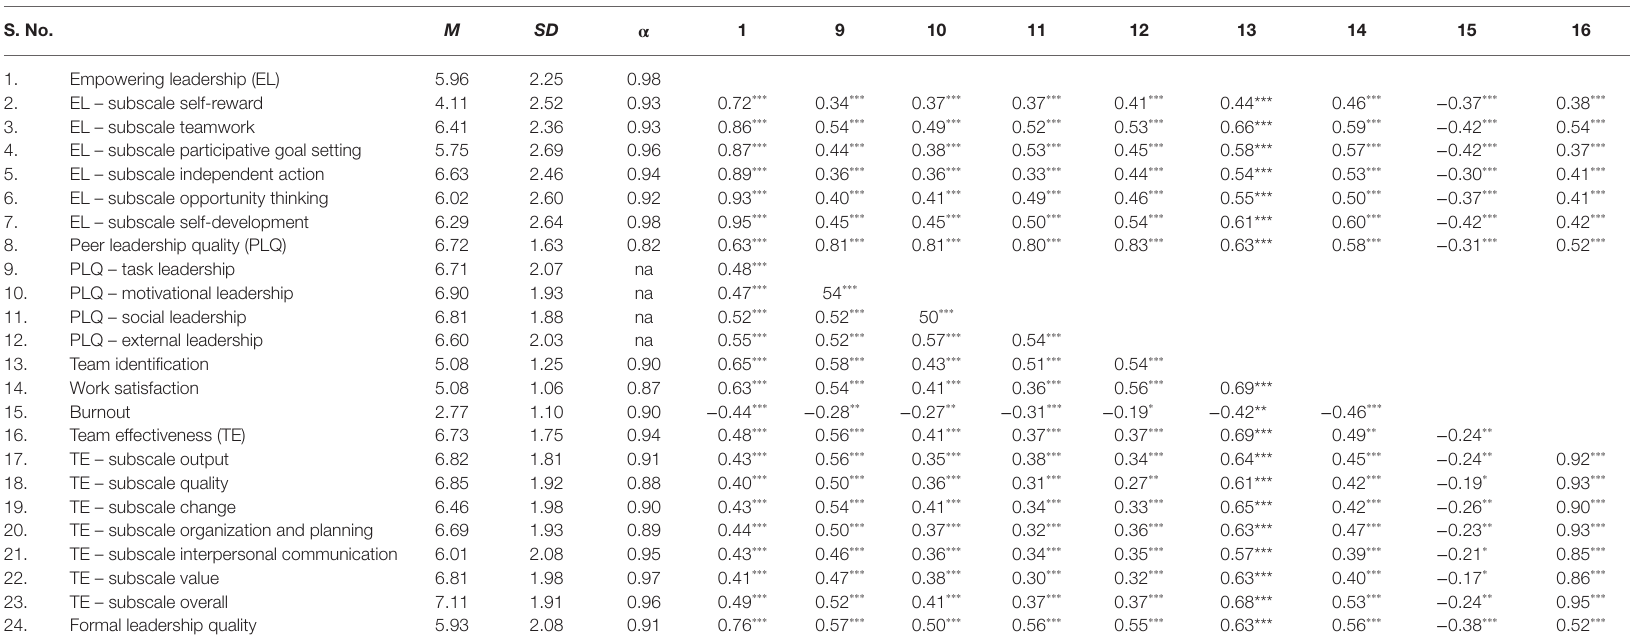
TABLE 1 | Means, standard deviations, and correlations between all included (sub)scales and their respective reliability. S.